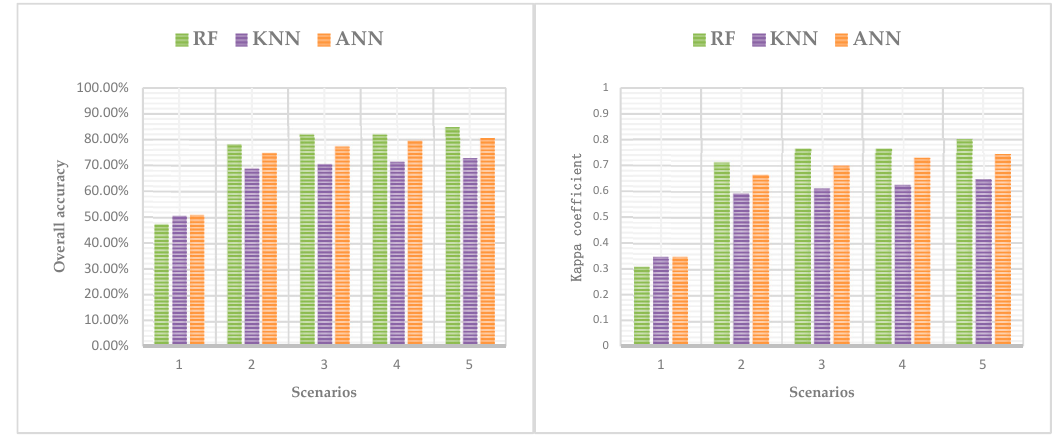
Figure 11. Comparison of the OA and kappa coefficient of RF, KNN, and ANN for five scenarios.